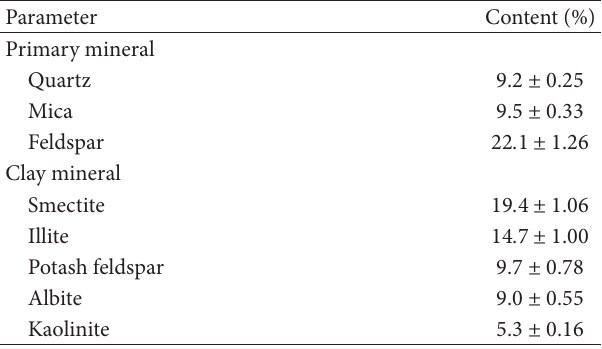
Table 3: Basic mineralogical properties of the initial alkaline soil.